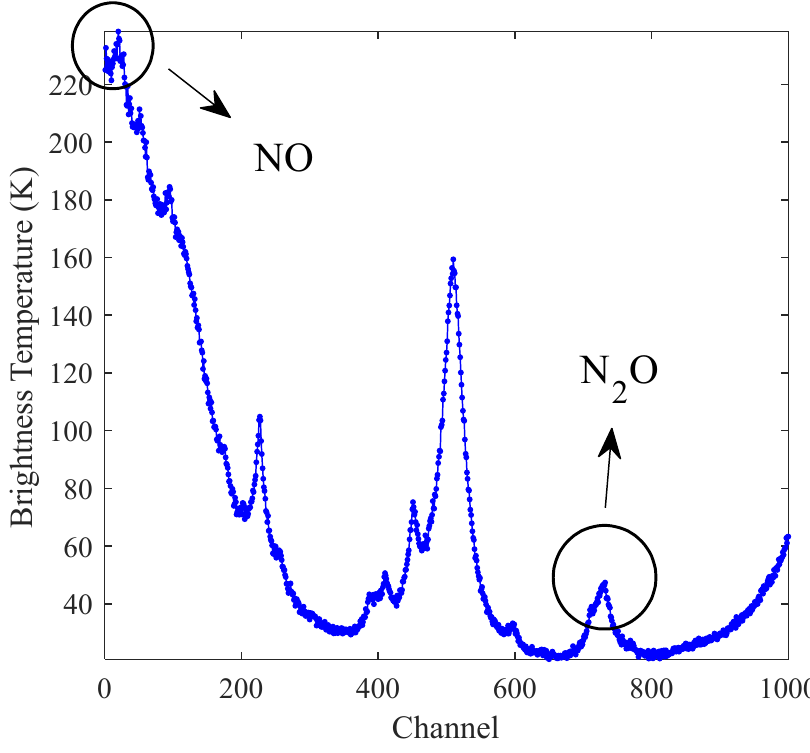
Figure 9. Output brightness temperature spectrum after system calibration.